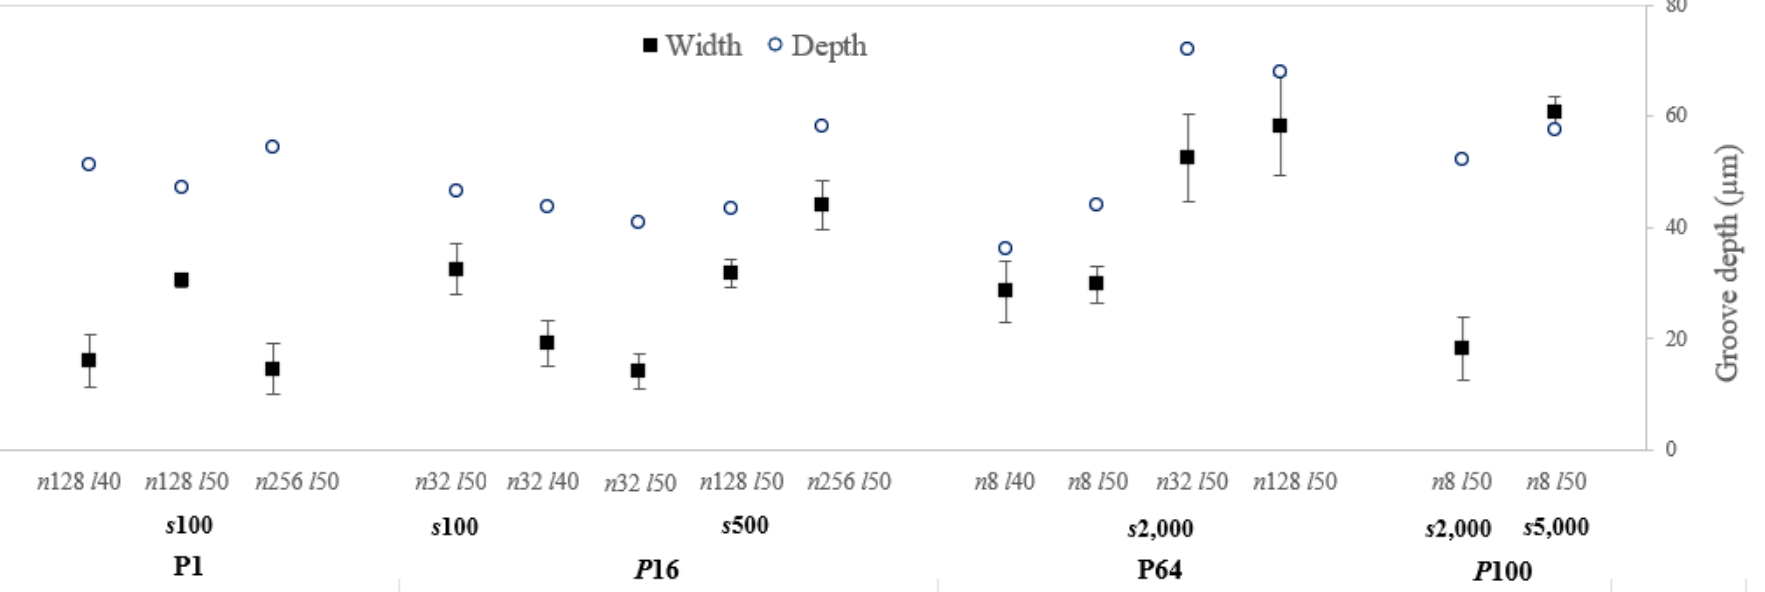
Figure 7. Width and depth in the middle of textured grooves obtained from different combinations of parameters ( P = laser power in %, s = scanning speed in mm/s, n = number of passes, and l = line spacing in µm) .